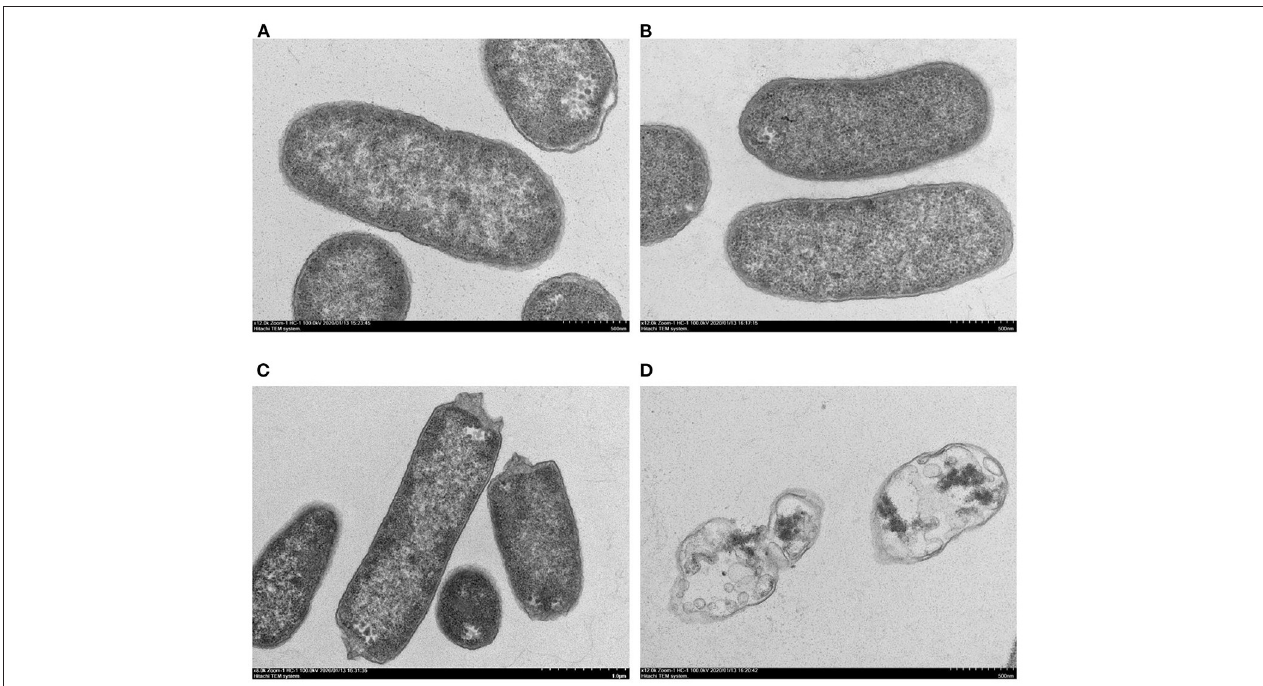
FIGURE 4 | TEM of E. coli K12 and E. coli JW0688 with and without plantaricin BM-1. (A,B) show wild type E. coli K12 and E. coli JW0688 without plantaricin BM-1, and (C,D) show E. coli JW0688 and E. coli K12 with plantaricin BM-1.